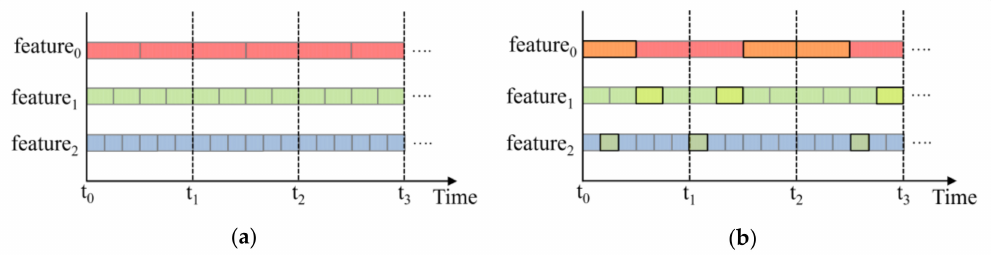
Figure 3. ( a ) Distribution of various features. ( b ) Extraction of the features in the timestamp. Step 1: Feature information extraction in the frequency